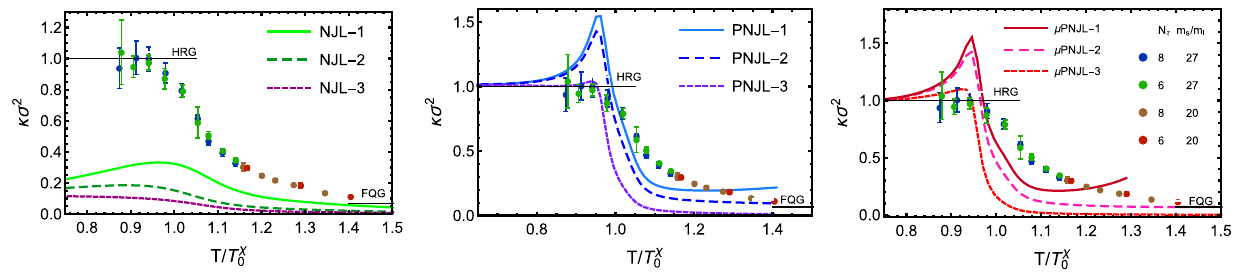
Fig. 1 The kurtosis of baryon number fluctuation κσ 2 as a func- tion of the temperature at zero baryon chemical potential in the NJL model, PNJL model and μ PNJL model, and compare with the lattice